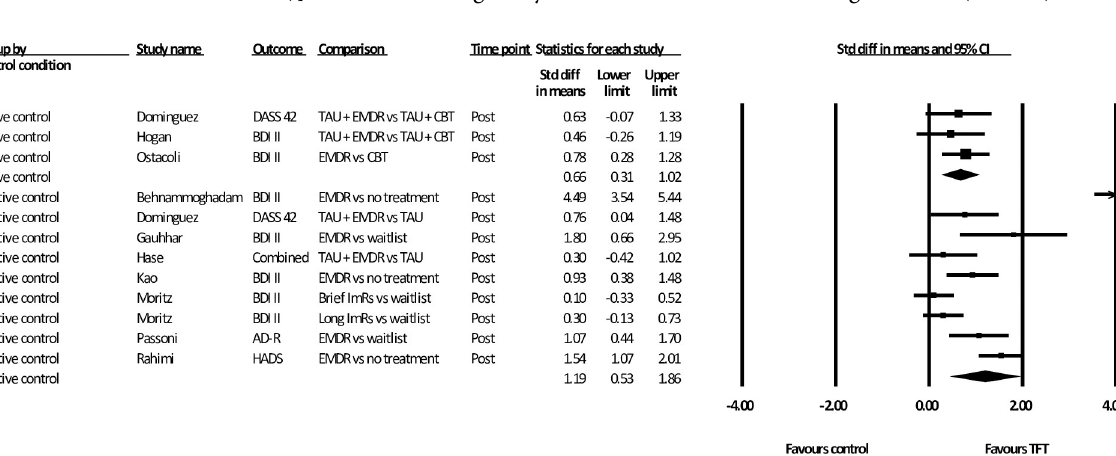
PLOS ONE | https://doi.org/10.1371/journal.pone.0254778 July 22,